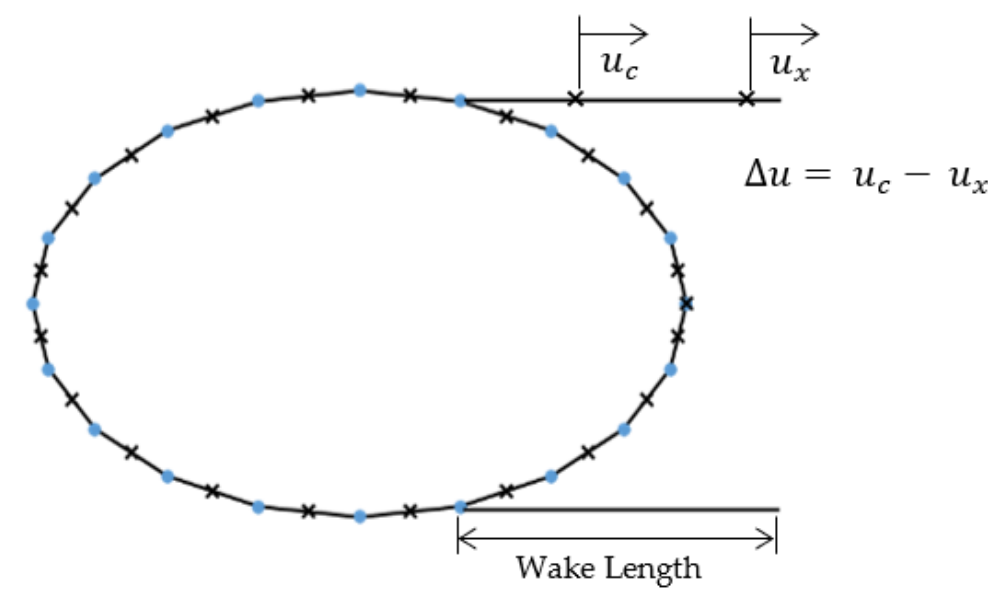
Figure 3. Calculation of tangential velocity increment along the wake panel.